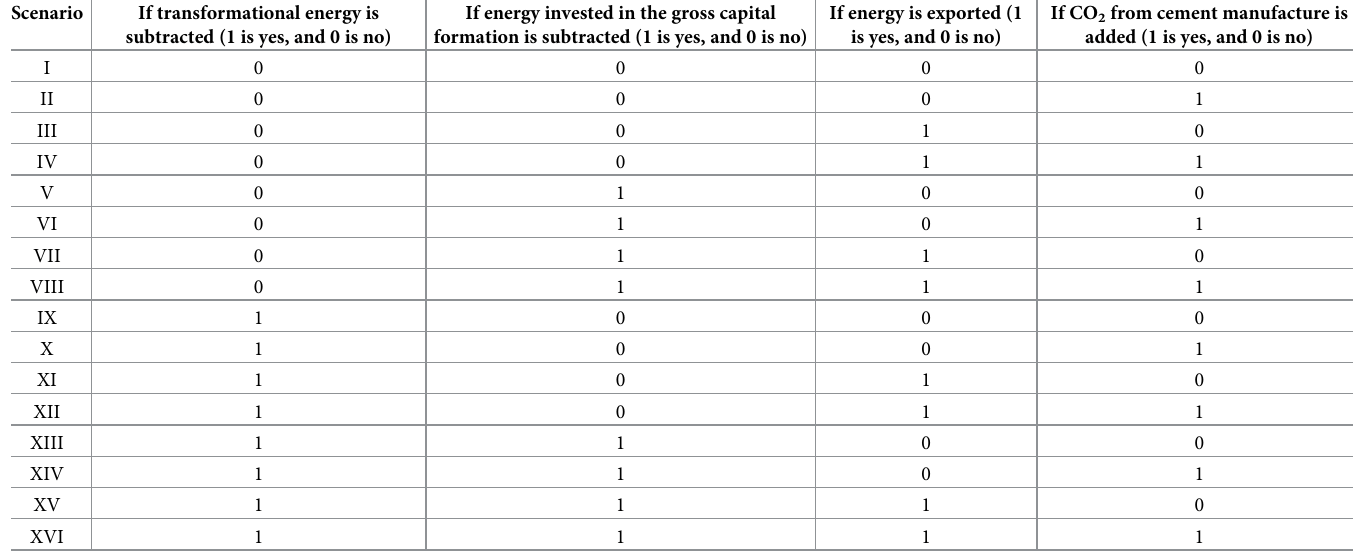
Table 1. Scenario design and